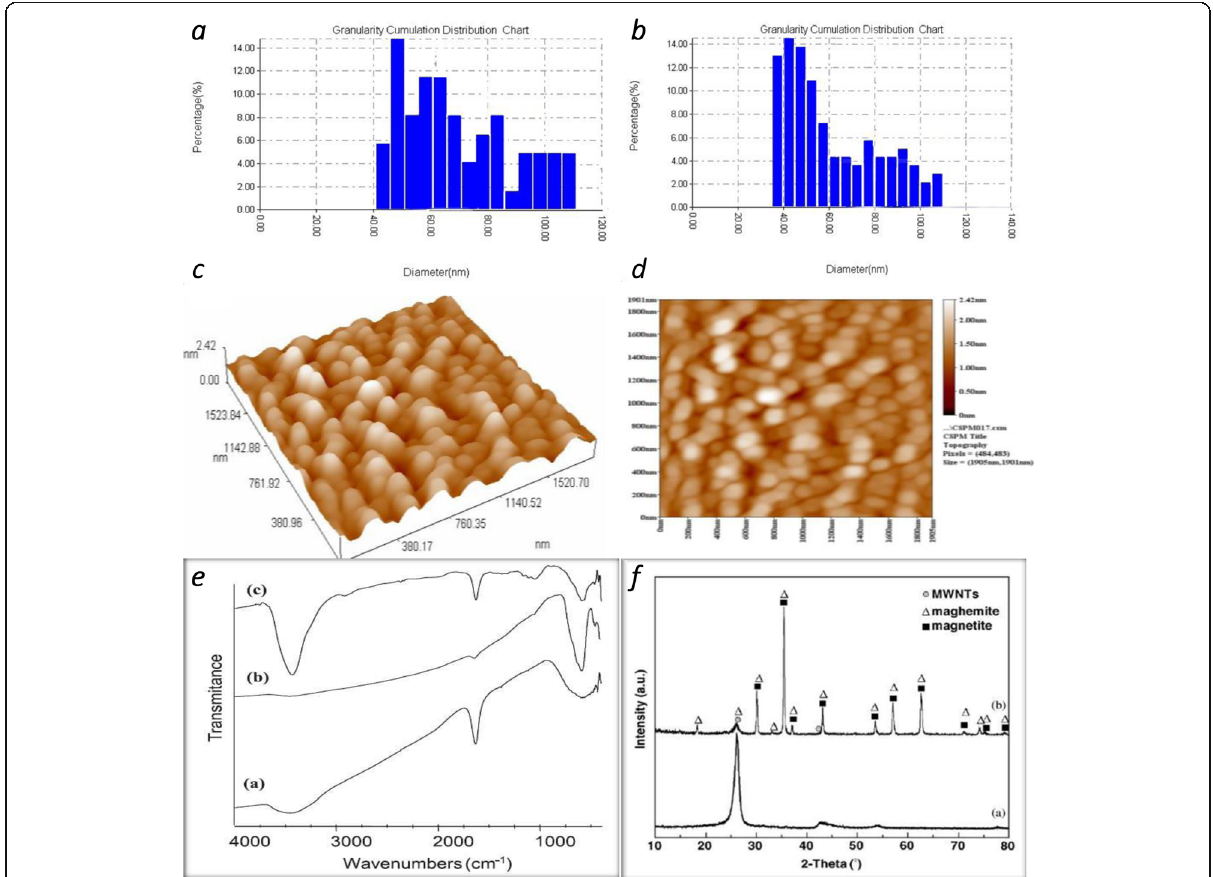
Fig. 1 AFM of Fe 3 O 4 /CNTs framework demonstrated a , b size distribution for catalyst Fe 3 O 4 /CNTs particle by AFM . c Prepared particles sketched on X – Y axis catalyst, while the d shows prepared particles sketched on X – Y – Z axis for catalyst. e FTIR spectra of a CNTs, b Fe 3 O 4 , and c Fe 3 O 4 / CNTs composite, f XRD pattern of a Fe 3 O 4 /CNTs and b decorated Fe 3 O 4 /CNTs (maghemite and